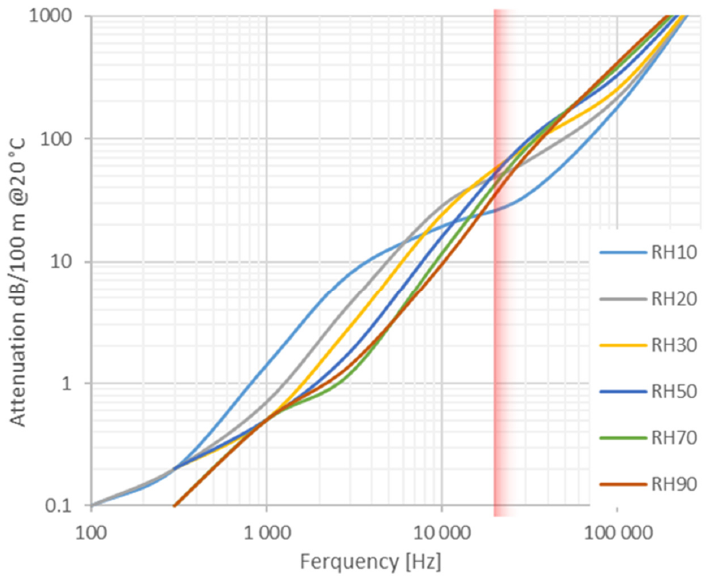
Figure 2. Attenuation of the acoustic wave vs. frequency and for different relative humidity ( RH from 10% to 90 %) calculated from the ISO 9613 ‐ 1:1993. It is evident that high frequencies have the disadvantage of a strong attenuation also depending on relative humidity. The red area indicates the operative frequencies chosen for the instrument.